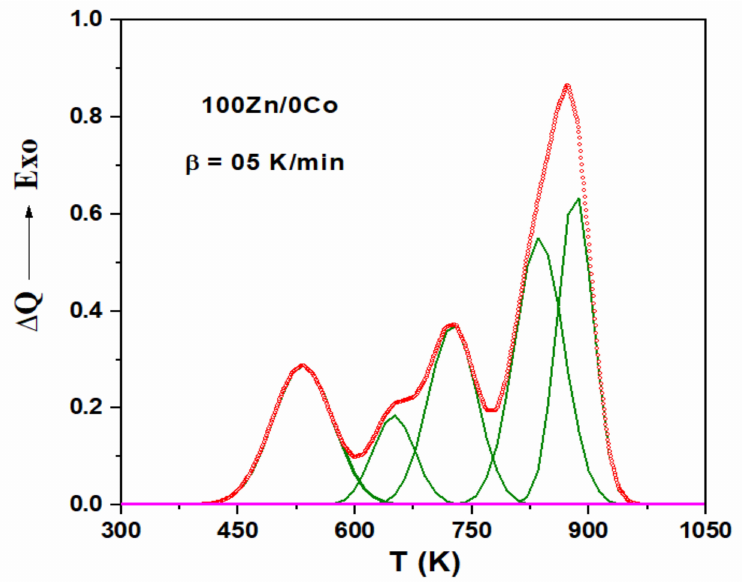
Figure 10. The deconvolution of overlapped exothermic peaks at heating rate β = 5